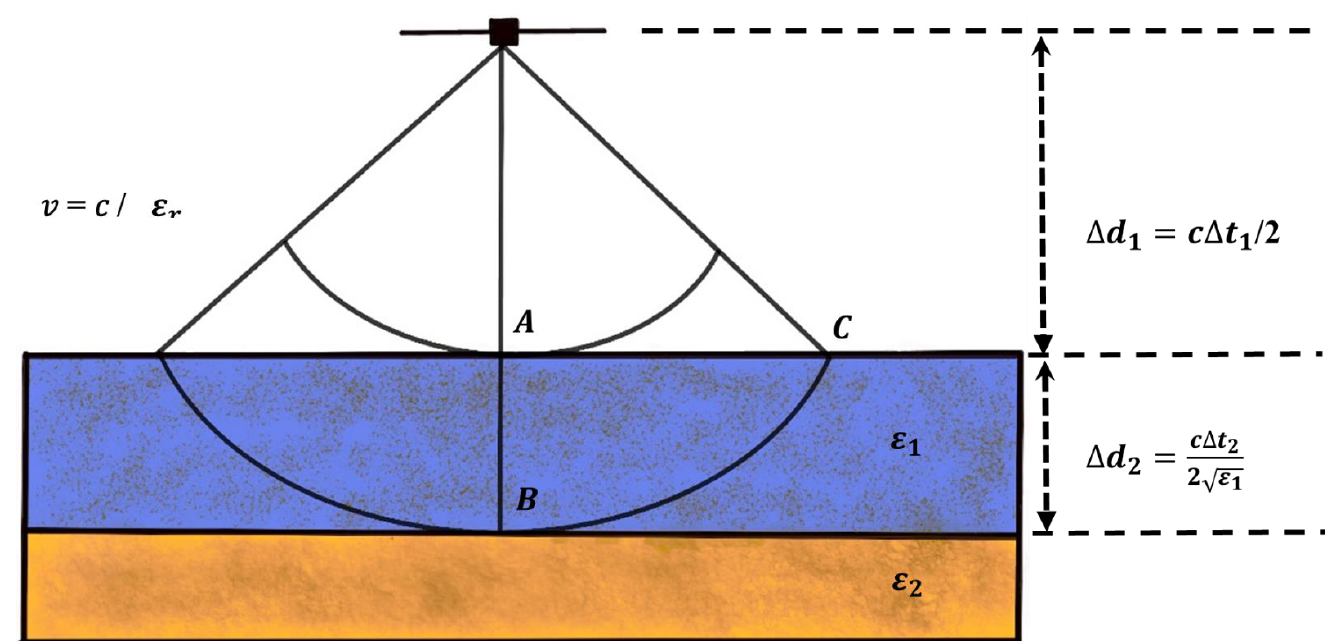
Figure 6. Principle of radar detection. ∆t 1 is the two-way time difference obtained when the electromagnetic wave emitted by the radar instrument reaches the surface of Mars, and ∆t 2 is the two-way time difference when the electromagnetic wave propagates from point A to point B.